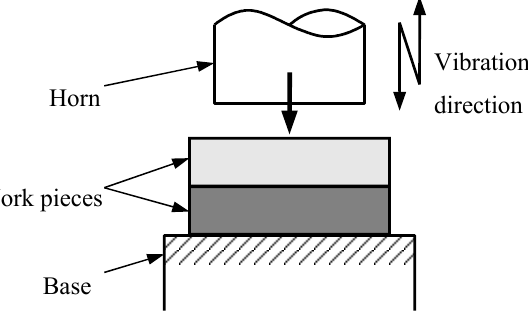
Figure 1. Schematic illustration of USW method. Adapted from Reference [106].